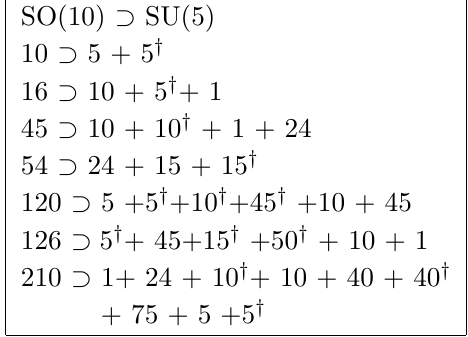
Table 1 . Decomposition of SO(10) representations into SU(5) representations [36{45].